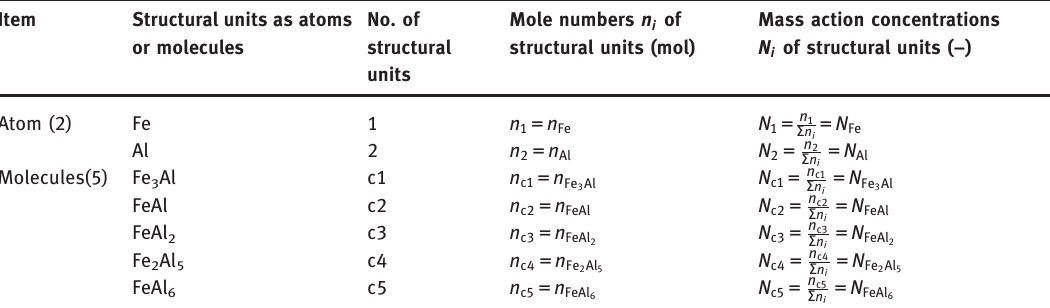
Table 3: Expressions of structural units as atoms and molecules, their equilibrium mole numbers n i , and mass action concentrations N i in 100g Fe – Al binary melts based on the